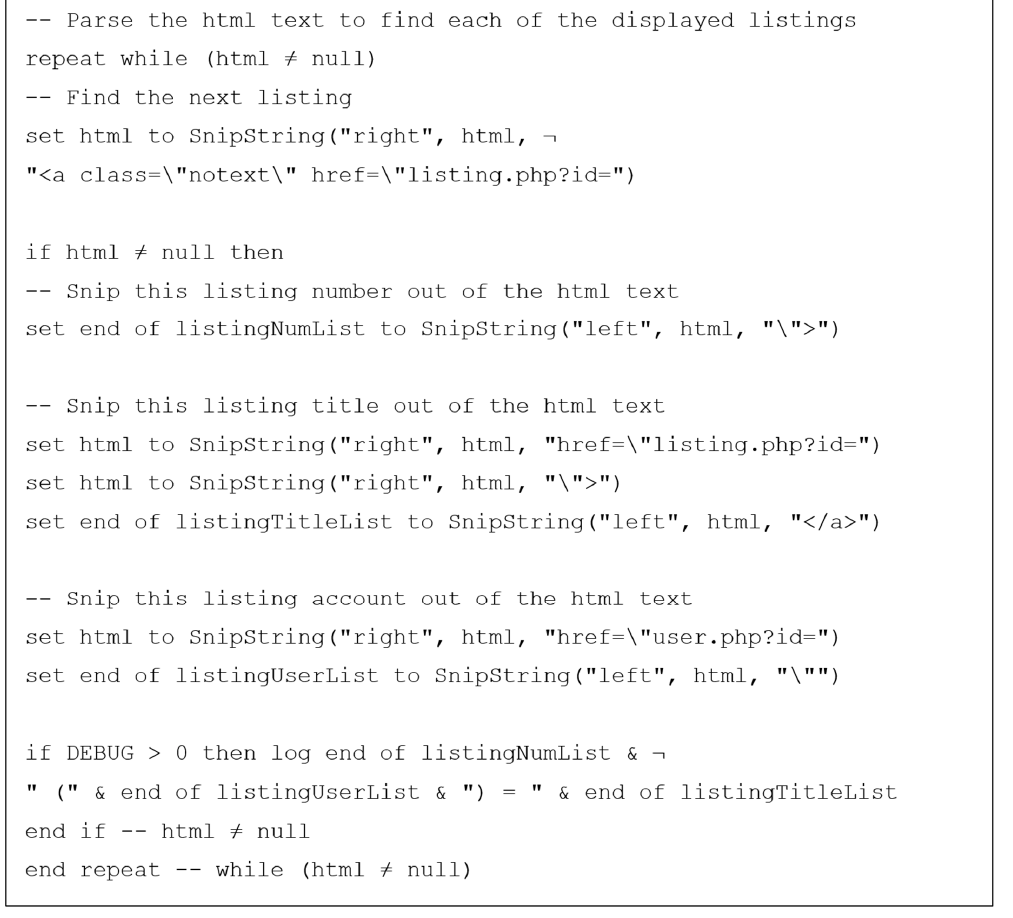
Figure A2. Sample Code Snippet for Product Scraping.